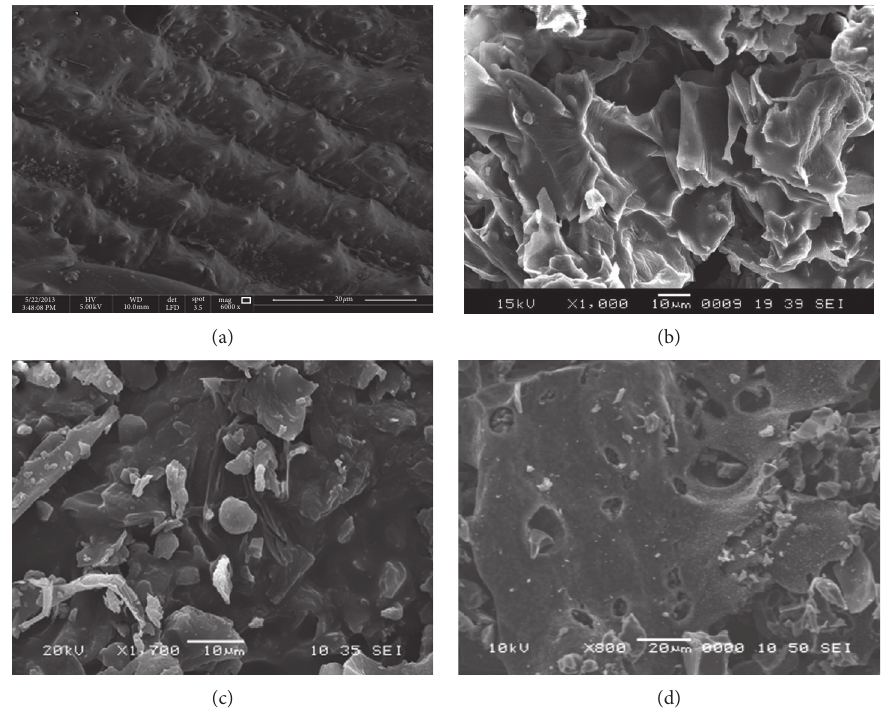
Figure 5: Scanning electron microscopy of PGP (a) [16], (b) [22], (c) [18], (d)